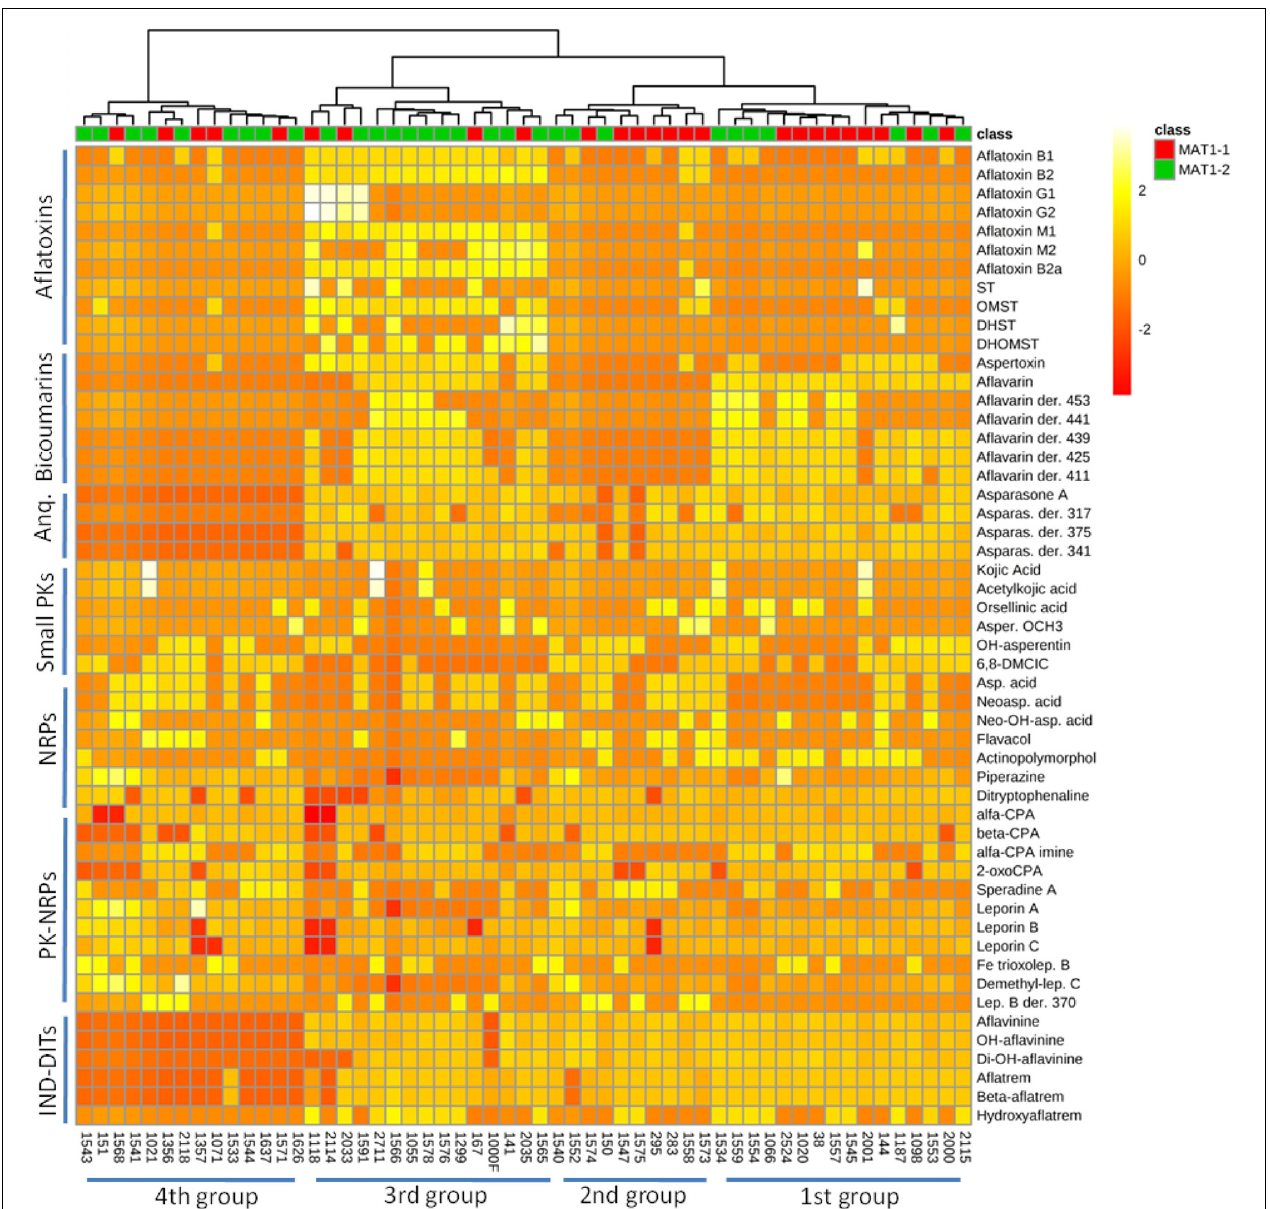
FIGURE 2 | Heat map representing metabolite distribution in 55 A. flavus isolates. On the top of the figure, a dendogram is depicted, clustering A. flavus isolates as function of mating-type genes ( MAT1-1 and MAT1-2 ) and metabolite occurrence. This figure was generated using the online metabolomics platform MetaboAnalyst 3.0 after the data were treated accordingly using sum normalization, log transformations and Pareto scaling. The data table was prepared using area under the curve (AUC) for each chromatographic peak of respective metabolites. Anq, anthraquinones; PKs, polyketides; NRPs, non-ribosomal peptides; IND-DITs, indole-diterpenoids; ST, sterigmatocystin; OMST, O -methylsterigmatocystin; DHST, dihydro-ST; DHOMST, dihydro-OMST; Asparas., asparasone A; Asper. OCH 3 , asperentin methyl-ether; 6,8-DMCIC, 6,8-dimethylcitreoisocoumarin; Asp. acid, aspergillic acid; Neoasp. acid, neoaspergillic acid; α -CPA, alfa-cyclopiazonic acid; Lep. B, leporin